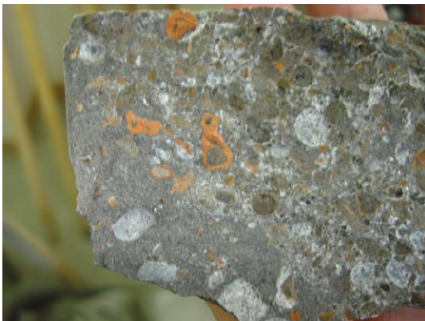
Figure 9: Specimen SCLC of the 2nd group after testing.